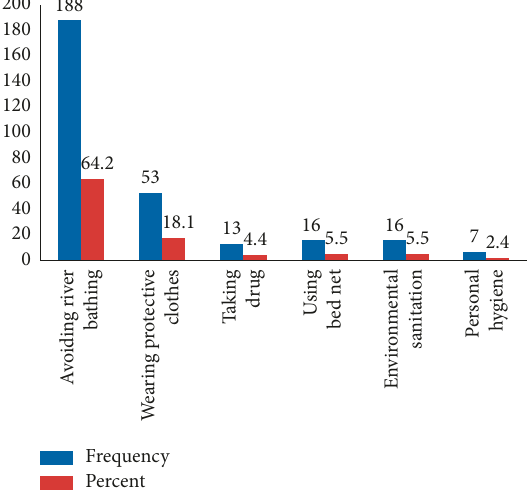
Figure 2: Prevention measure taken by the community towards the elimination of onchocerciasis from Gesha town,